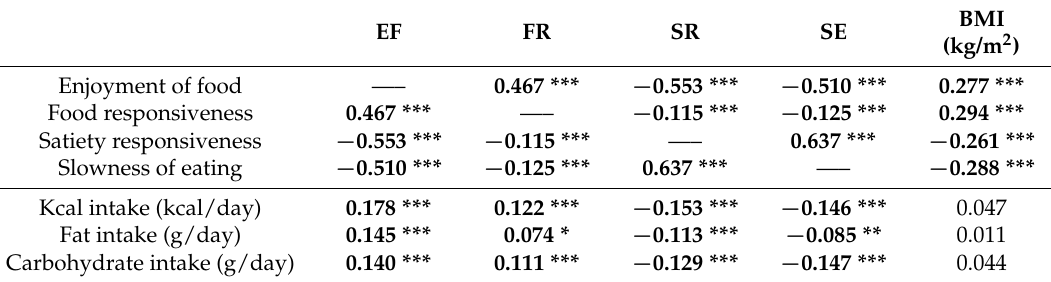
Table 3. Correlations between offspring’s food intake, eating behaviour and